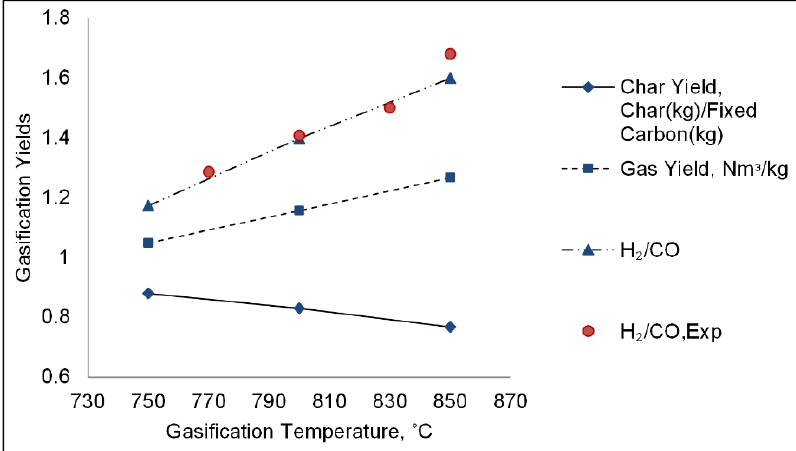
Figure 7. The effect of gasification temperature on the system yields, S / B = 0.84.